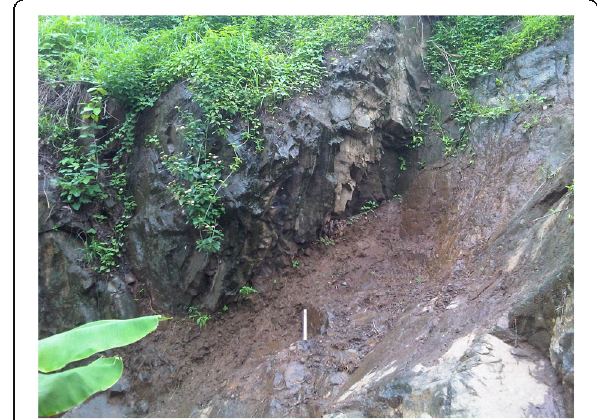
Fig. 5 The condition of groundwater flowed through joints to the surface of andesite rocks. The groundwater flows consistently and weathers the underneath rock surfaces. The photo was taken at Station 1 with a 30 cm ruler as a